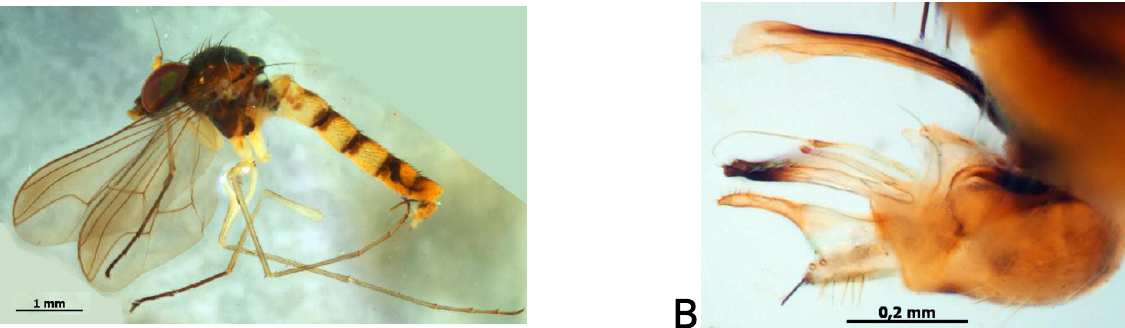
Figs. 5. Sciapus adumbratus (Becker, 1902): A-male habitus; B-hypopygium.